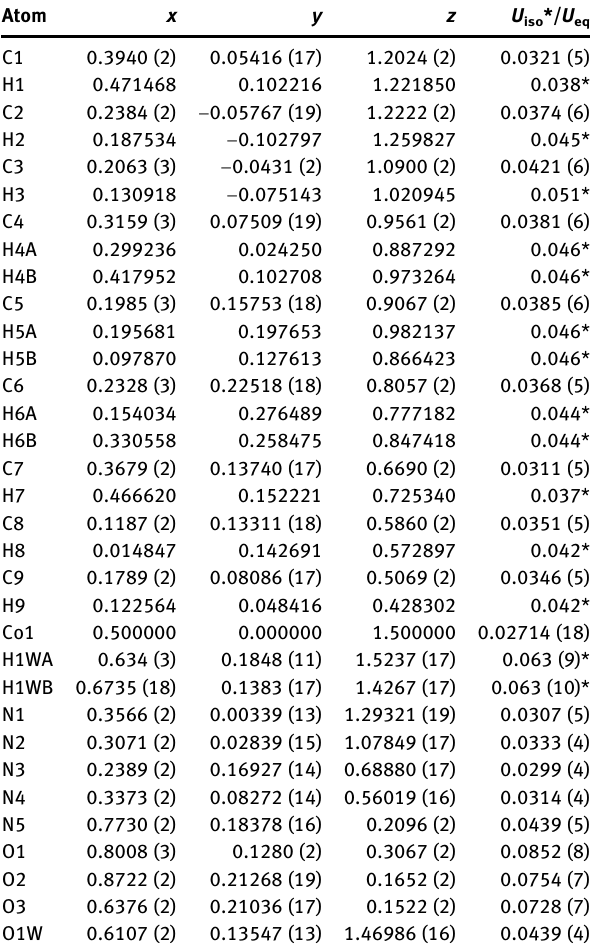
Table  : Fractional atomic coordinates and isotropic or equivalent isotropic displacement parameters (Å 